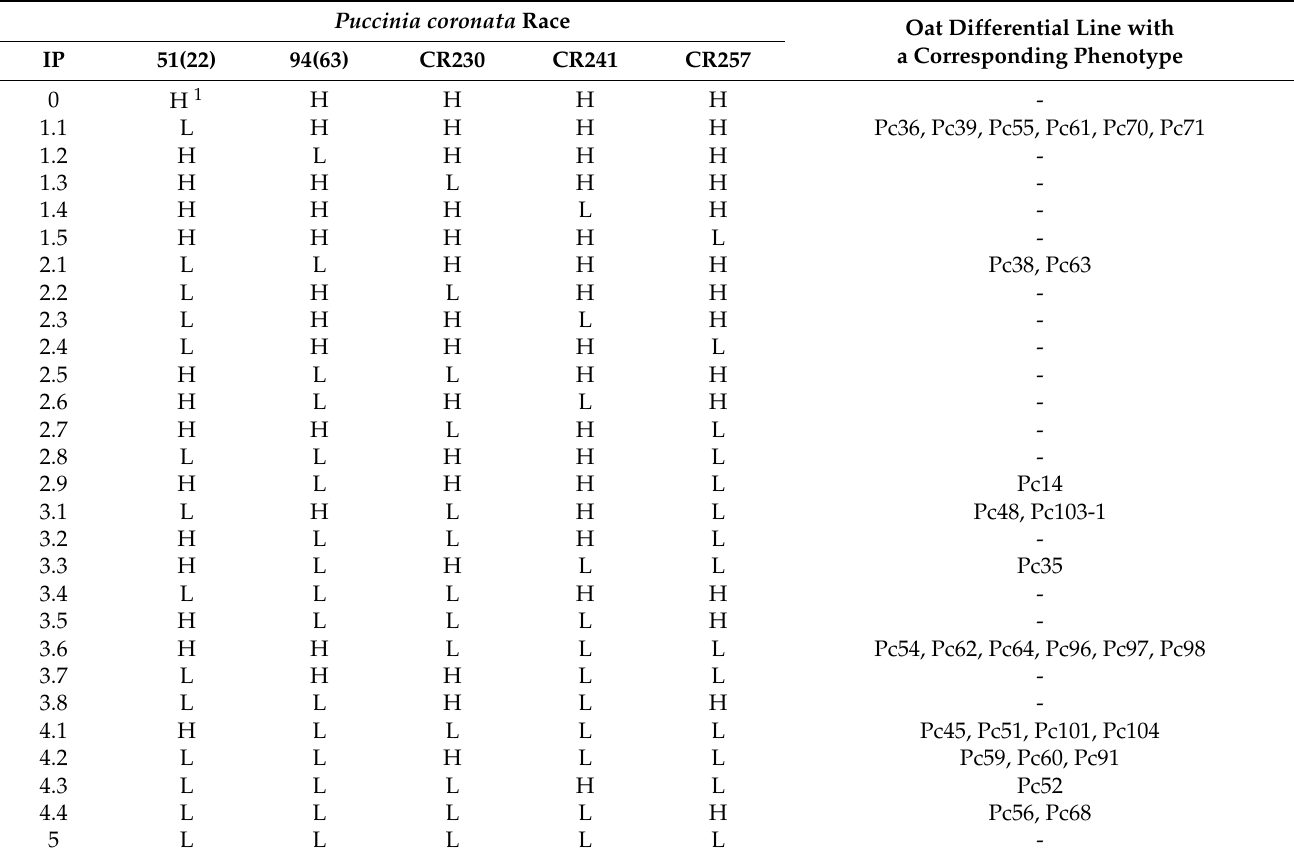
Table 2. The infection profiles (IP) of the tested A. strigosa accessions based on the reaction to P. coronata race